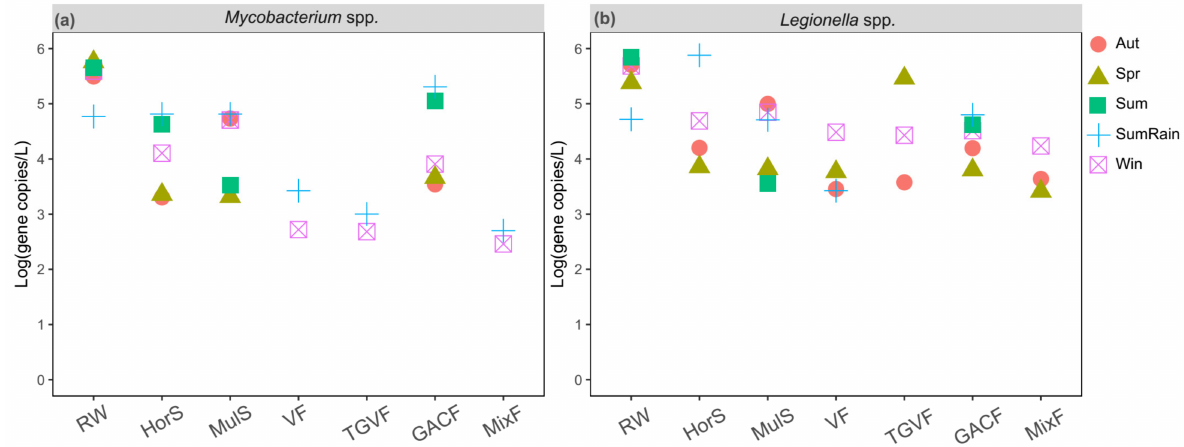
Figure 3. Target opportunistic pathogens, including ( a ) Mycobacterium spp. and ( b ) Legionella spp., in water samples at different water treatment stages and at different sampling time points. RW, HorS, MulS, VF, TGVF, BACF, and DisF were the abbreviations of raw water, horizontal flow sedimentation, Multiflo sedimentation, V-type filtration, TGV filtration, O 3 -BAC filtration, and disinfection, respec- tively. The different colors and shapes represent different seasons. The results of summer rainfall sample were removed due to insufficient DNA volume which cannot be used to verify the primary qPCR results.